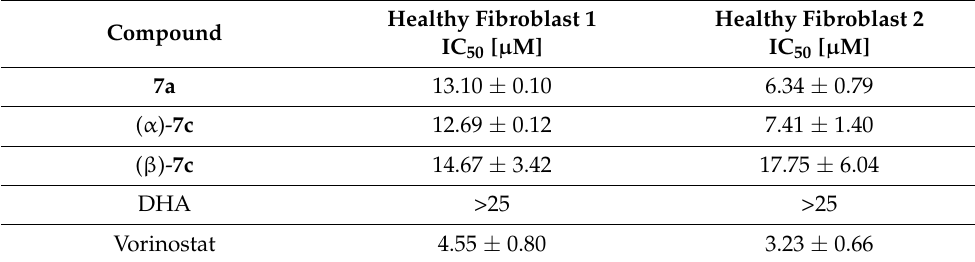
Figure 5. Apoptosis assay via annexin V/PI measurement after 48 h treatment of K562 cells with the respective inhibitors at the depicted concentrations. Significance was calculated using the sum of (early and late) apoptotic cells and necrotic cells vs. vehicle control (DMSO) from three independent measurements, using one-way ANOVA test (nonsignificant or ns, *** p < 0.0005 and **** p < 0.0001). Table 4. IC 50 Values of DHA–HDACi hybrids for two healthy fibroblast cells.